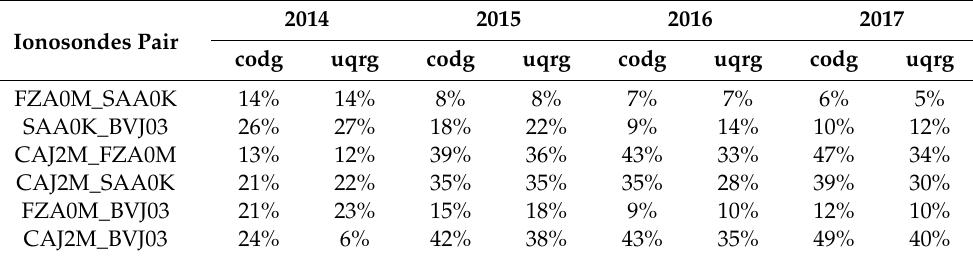
Table 7. Rates of improvement considering one-year mean RMS values of the di ff erences between fo F 2 values measured and estimated with two GIMs products (CODG and